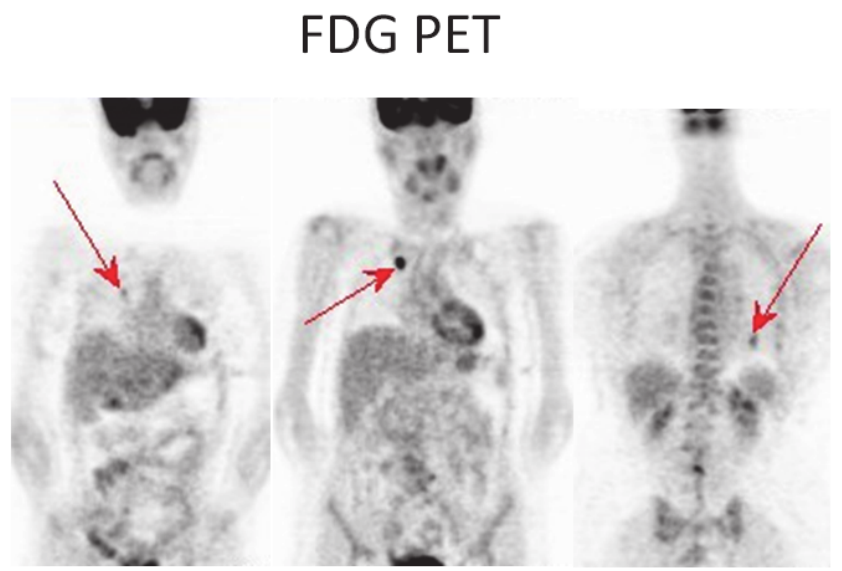
Fig. 2. Visualization of lung metastases by [ 18 F] fluorodeoxyglucose (FDG) positron- emission tomography (PET). FDG PET in May 2007 demonstrated multiple metastases bilaterally in the lungs